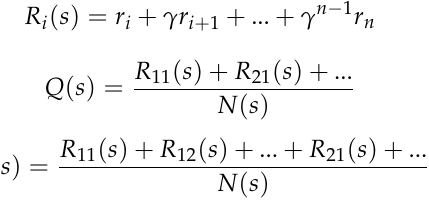
Figure 6. Episodes in Monte Carlo.